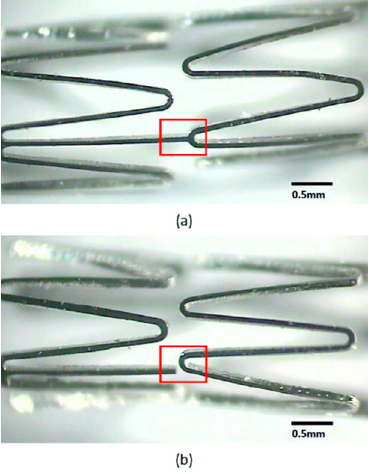
Figure 10. Photographs of the fabricated ( a ) multi-connector stent, and ( b ) single-connector stent placed vertically.